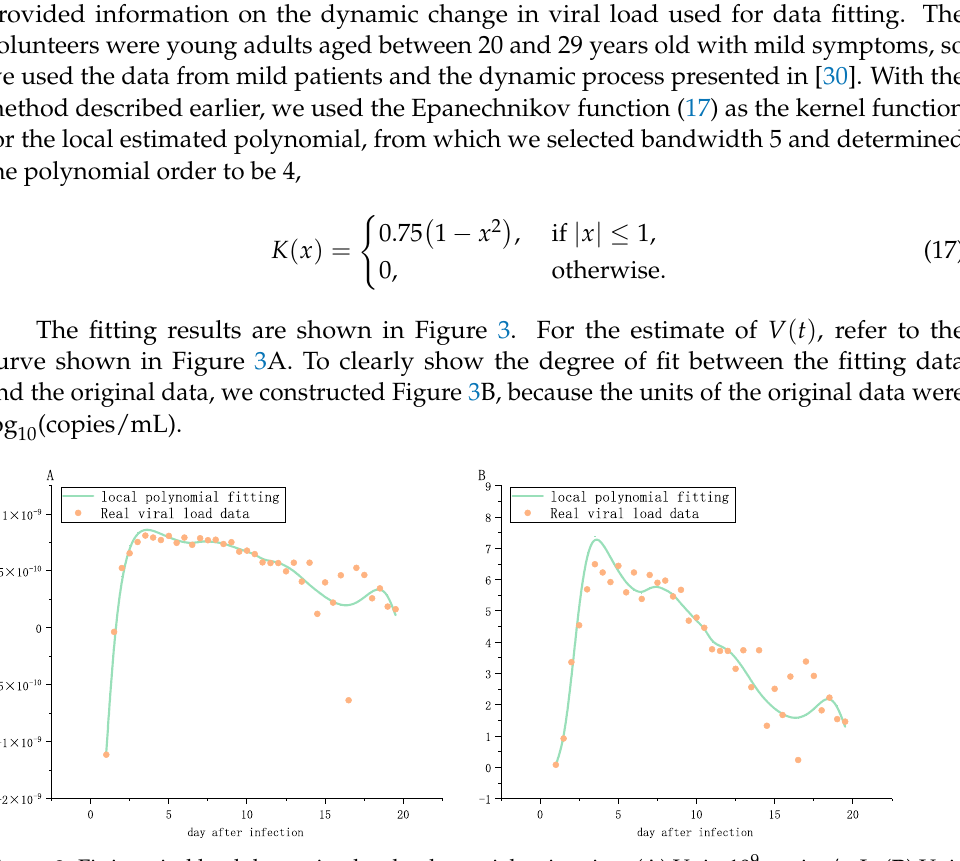
Figure 3. Fitting viral load data using local polynomial estimation. ( A ) Unit: 10 9 copies/mL; ( B ) Unit: log 10